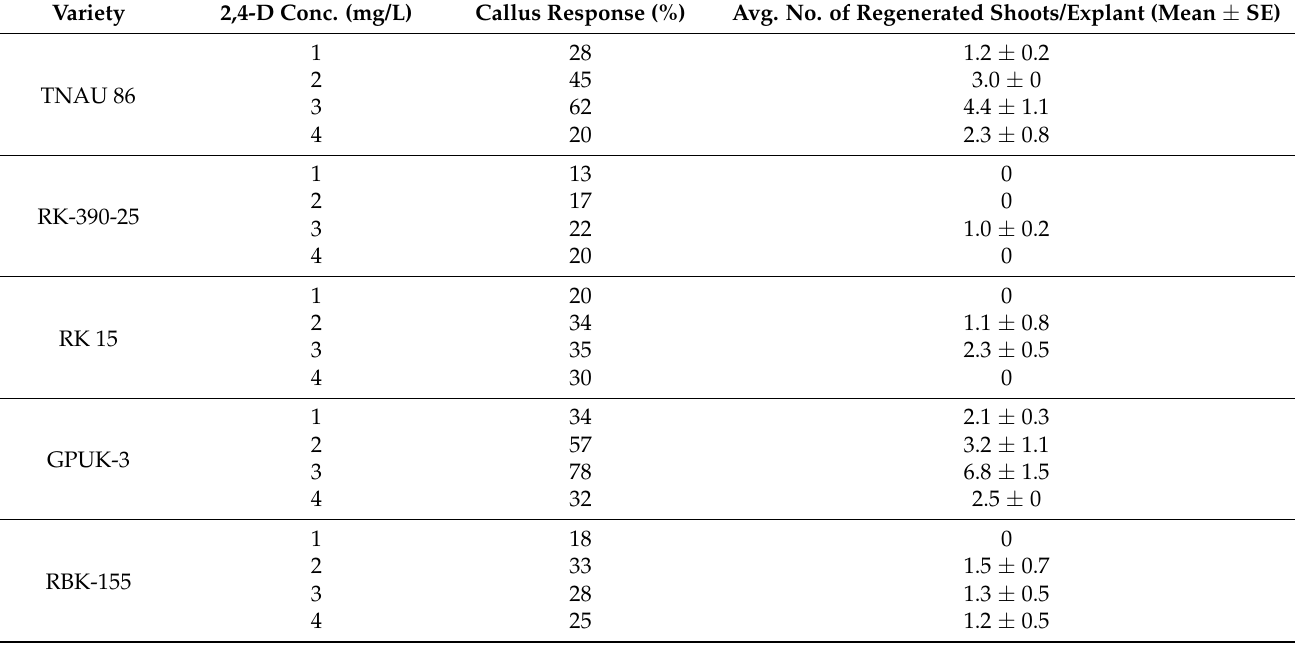
Table 3. Screening of morphogenetic competence among different varieties of P. scrobiculatum L. cultured on MS medium containing different concentrations of 2,4-D. Variety 2,4-D Conc.